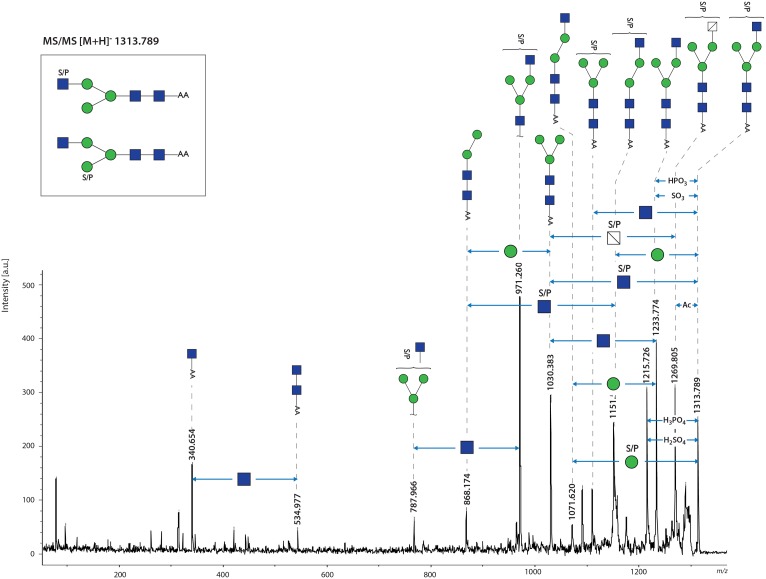
FhTeg N-glycans carry core fucose and are sulphated/phosphorylated on terminal N-acetylglucosamine and mannose residues.The sulphated/phosphorylated glycan observed at m/z 1313.6 [M-H]- in Fig 1 was analysed by MALDI-TOF- MS/MS. Differences in monosaccharides and functional groups content are indicated by double headed arrows.